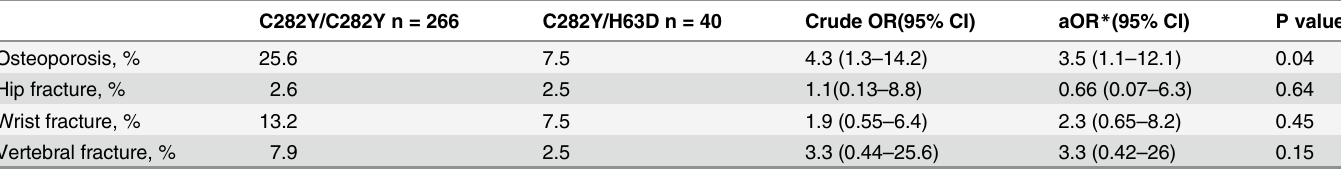
Table 4. Prevalence of osteoporosis and associated fractures by